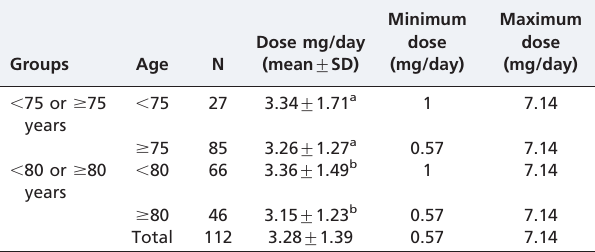
(Table 1). To achieve INR2-3, 88 (79%) patients received daily warfarin doses of 2 to 5 mg; 13 (11%) patients received doses